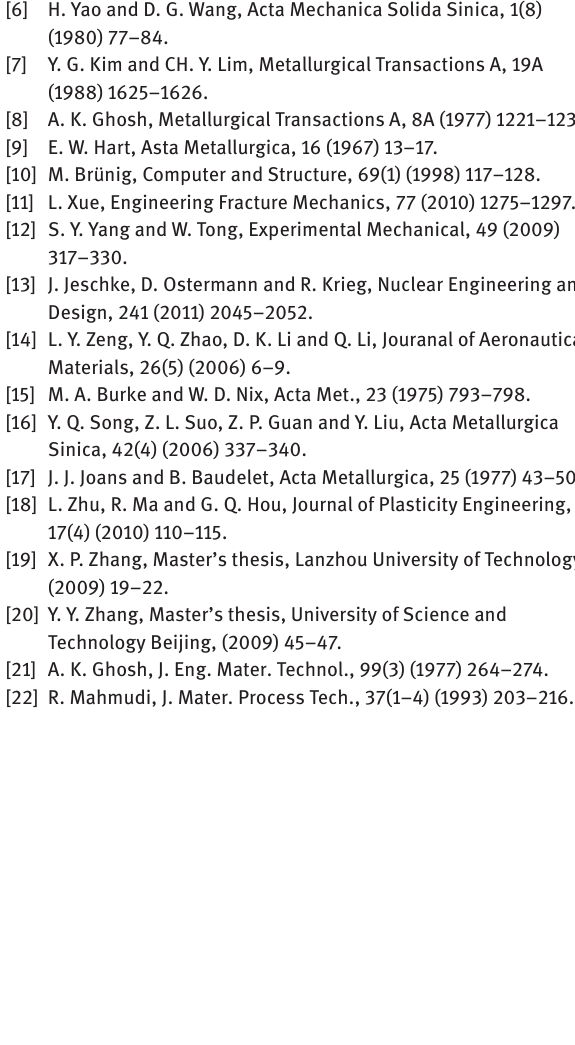
on strain rate sensitivity coefficient m . The strain increases with the increase of m and is the main part of geometrical instability